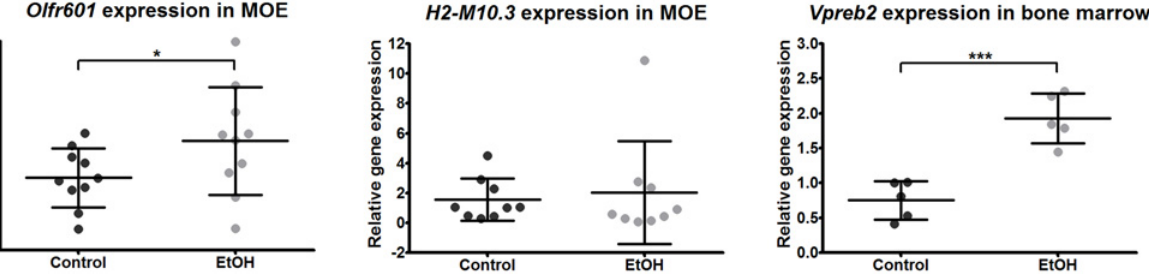
Fig 1. Effects of gestational alcohol exposure on gene expression in main olfactory epithelium and bone marrow. Quantitative PCR studies showed increased expression of Olfr601 in main olfactory epithelium (MOE) and Vpreb2 in bone marrow ( * p < 0.05 and *** p < 0.001, respectively, one-tailed Student ’ s t-test) of ethanol-exposed (EtOH) offspring relative to reference gene Rps16 . Expression of H2-M10 . 3 was not significantly changed in MOE (p = 0.35, one- tailed Student ’ s t-test). Each dot represents an individual four-week-old (P28) male mouse. Bars are averaged values ± SD.